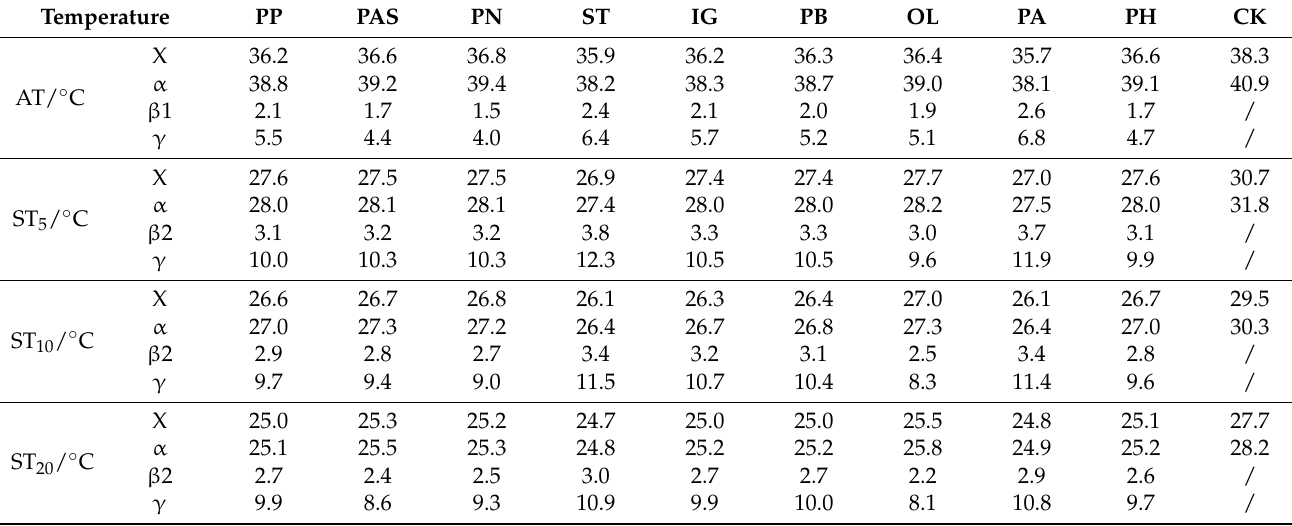
Table 2. Comparison of AT and ST in the different communities in summer.